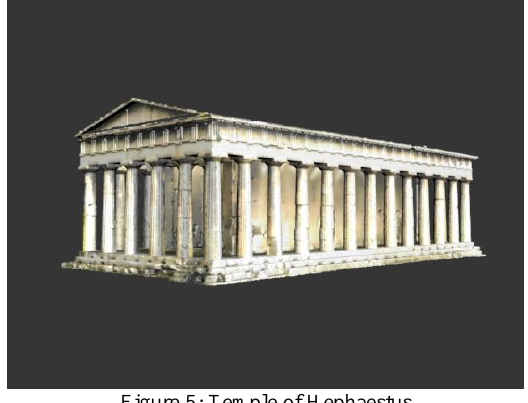
Figure 5: Temple of